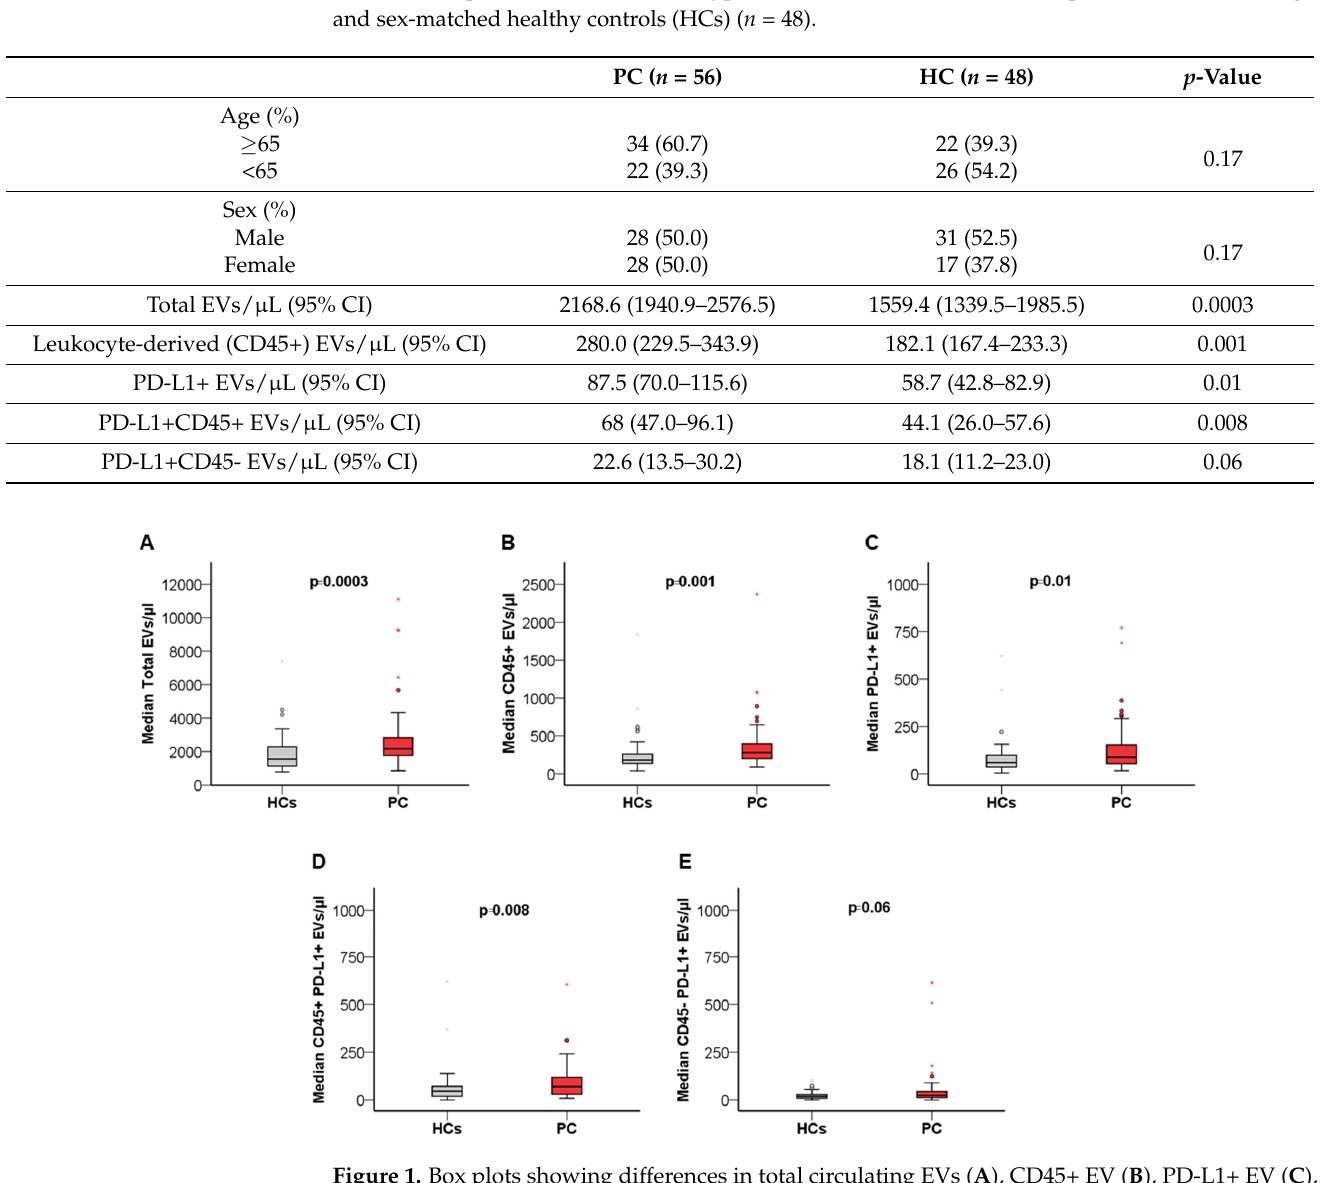
Figure 1. Box plots showing differences in total circulating EVs ( A ), CD45+ EV ( B ), PD-L1+ EV ( C ), CD45+PD-L1+ EV ( D ), and CD45-PD_L1+ EV ( E ) concentration between patients with PC ( n = 56) and healthy controls ( n = 48). Statistical comparison was performed by applying the Mann–Whitney U test. Circles and stars represent outliers. For visual clarity, highest extreme values are not shown.